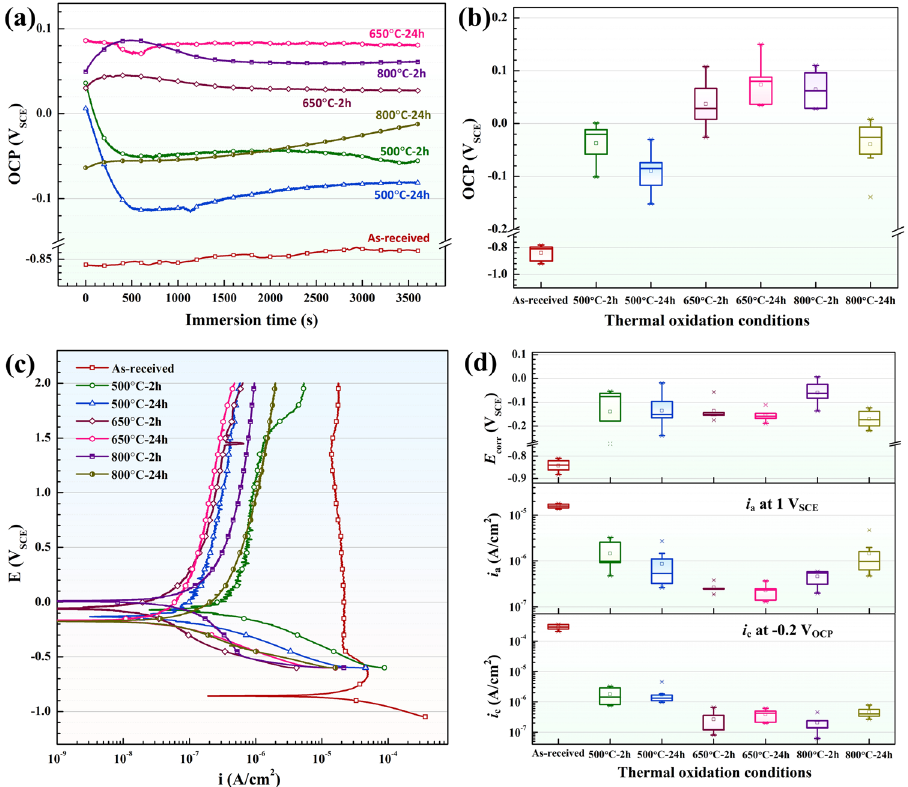
Fig. 4 OCP and potentiodynamic polarization of the as-received and thermally oxidized pure Ti in the simulated condensates. a open circuit potential, b the steady-state OCPs, c polarization curves and d the corrosion potential, the anodic current density at 1 V SCE , and the cathodic current density at − 0.2 V vs.OCP calculated from c . Error bars represent standard deviations of three independent samples from triplicate systems.